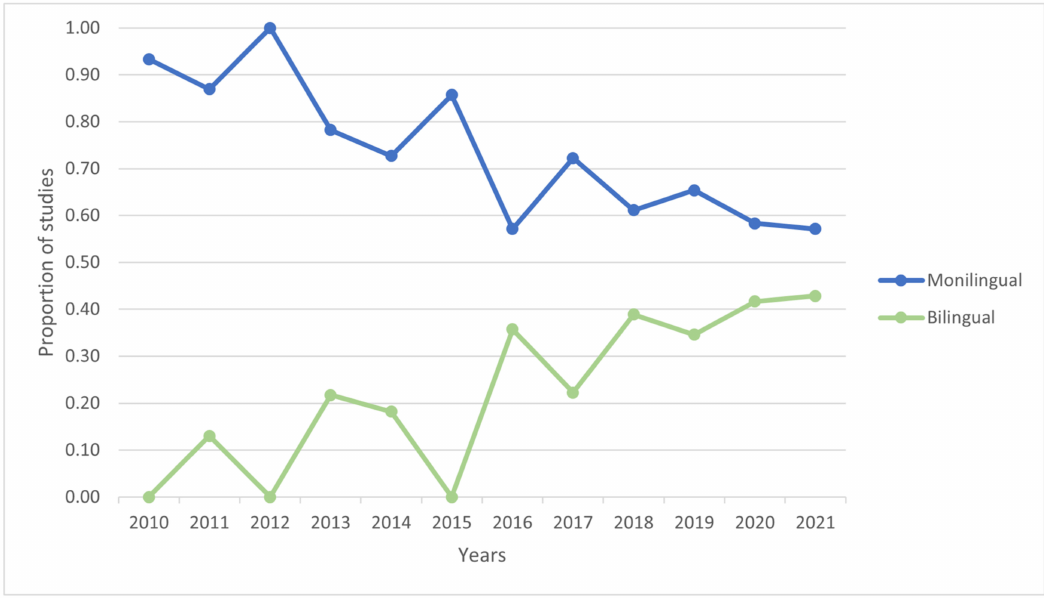
Figure 2. Proportion of monolingual and bilingual studies published between 2010 and